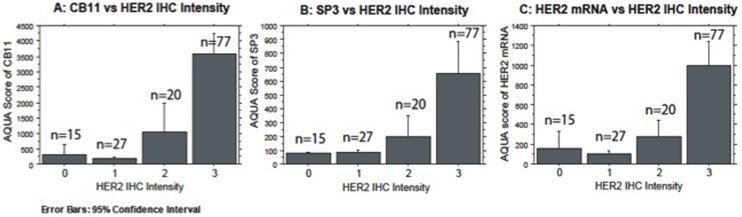
Comparison of CB11 (A), SP3 (B), Her2mRNA (C) to Her2 IHC.